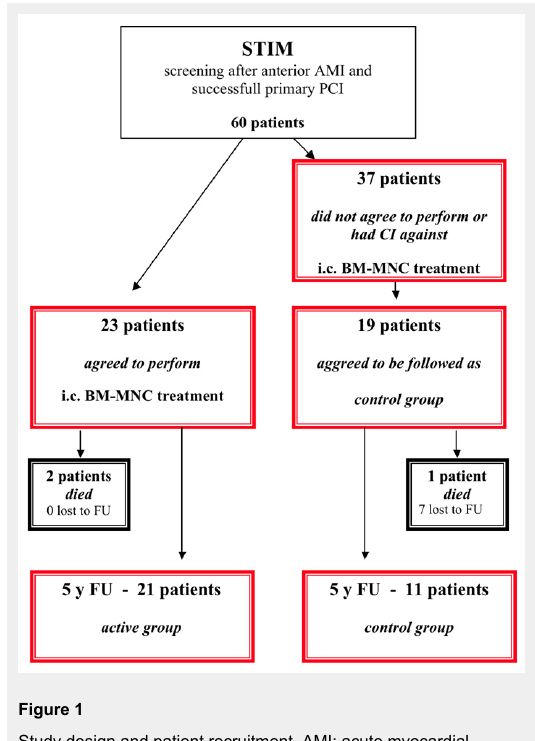
Study design and patient recruitment. AMI: acute myocardial infarction. PCI: percutaneous coronary intervention. i.c.: intracoronary. BM-MNC: autologous bone marrow derived mononucleated cells. FU: follow-up.